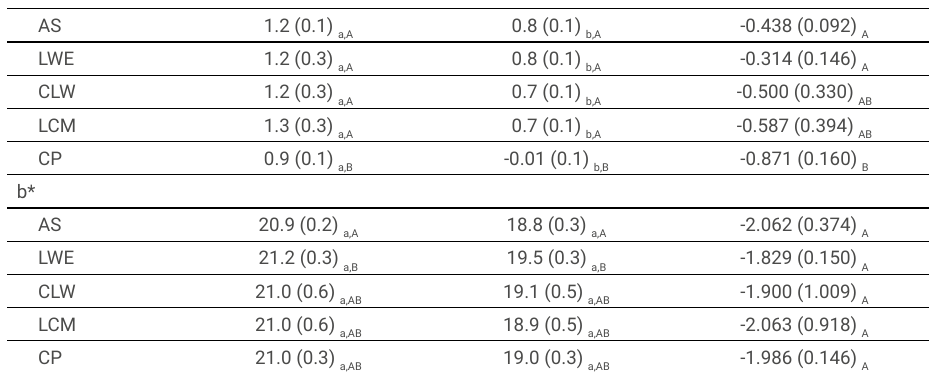
Lower case letters represent the comparison of groups in lines; capital letters represent the comparison of groups in columns; different letters reveal statistically significant differences in comparisons